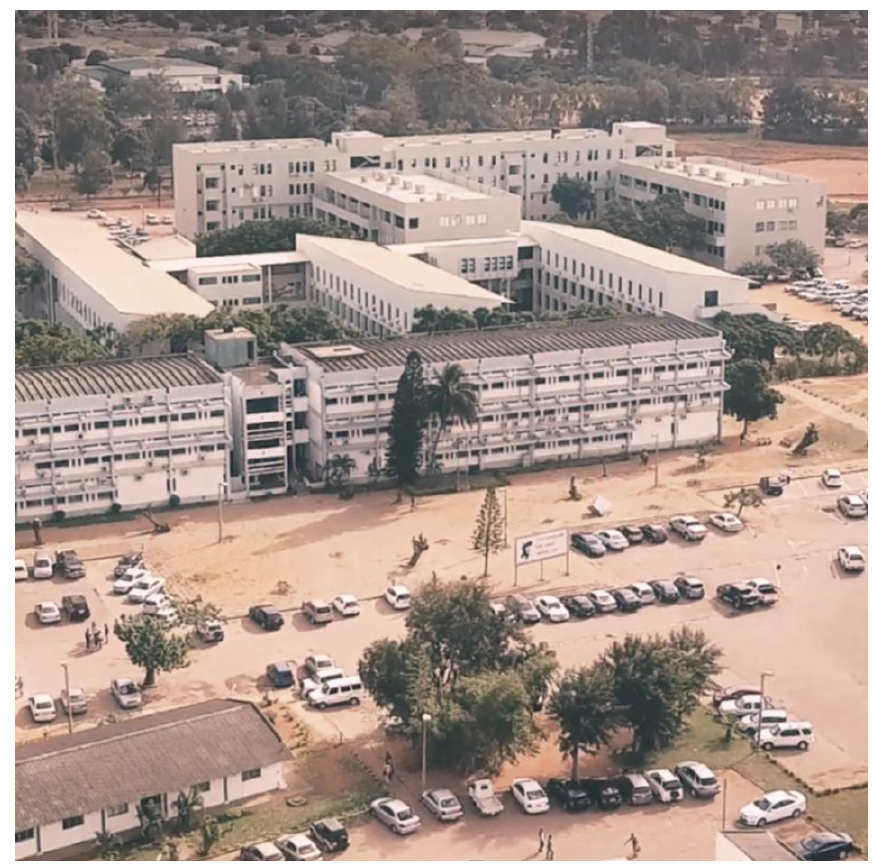
Figure 3. Existing modular blocks. The Department of Mathematics and Computer Science is the only building to resume the setting for “grafts” that characterizes the Plan.